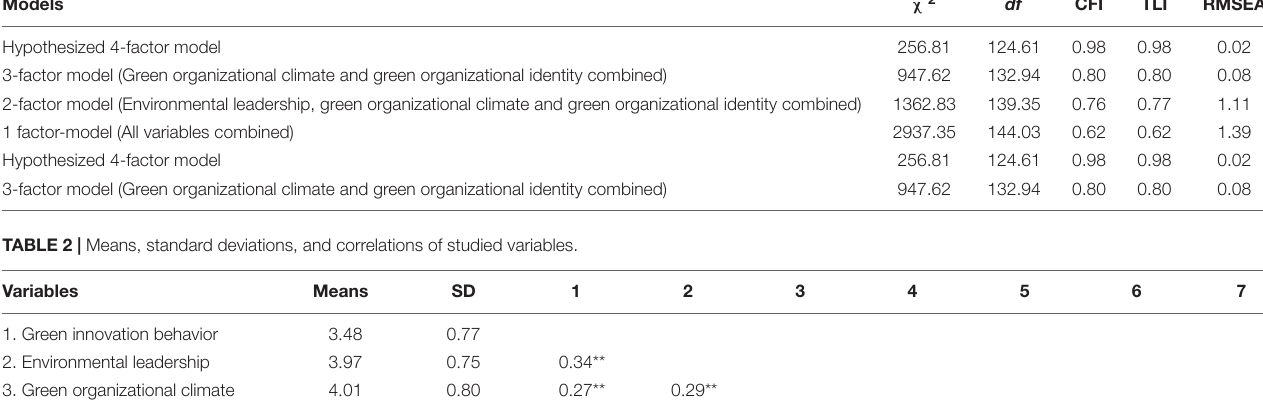
TABLE 1 | Measurement model fit results. Models